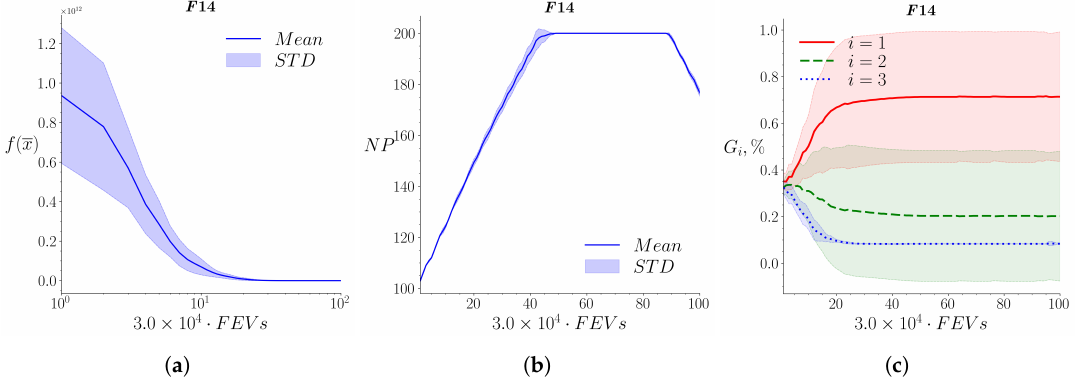
Figure A14. The dynamics of COSACC-LS1 on the F14 problem: ( a ) Convergence; ( b ) Population size; ( c ) Redistribution of resources.